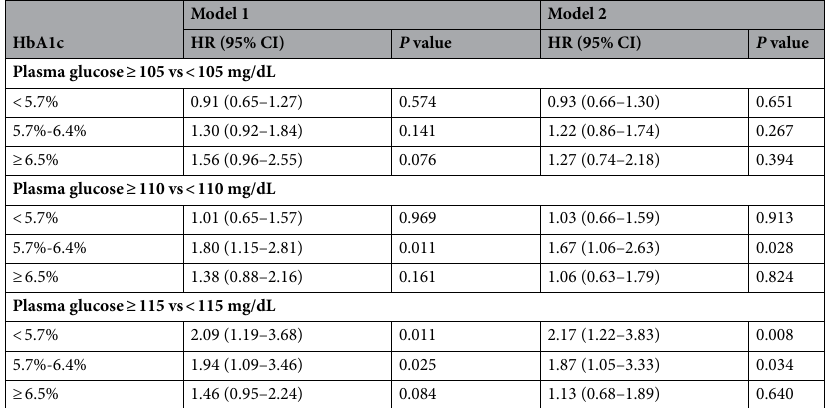
Table 4. Sensitivity analysis of CVD mortality risk associated with late non-fasting plasma glucose (dichotomous) in 4042 participants, a stratified by HbA1c. CI, confidence interval; CVD, cardiovascular disease; HbA1c, hemoglobin A1c; HR, hazard ratio. a The late non-fasting sub-cohort included 5564 participants, among which 1522 died of non-CVD causes. This sensitivity analysis was conducted on the remaining 4042 participants after exclusion of these 1522 participants. Model 1: adjusted for age, sex, ethnicity, obesity, education, poverty-income ratio, survey period, physical activity, alcohol consumption, smoking status, self-reported hypertension, and self-reported hypercholesterolemia. Model 2: adjusted for all the factors in Model 1 plus natural log-transformed